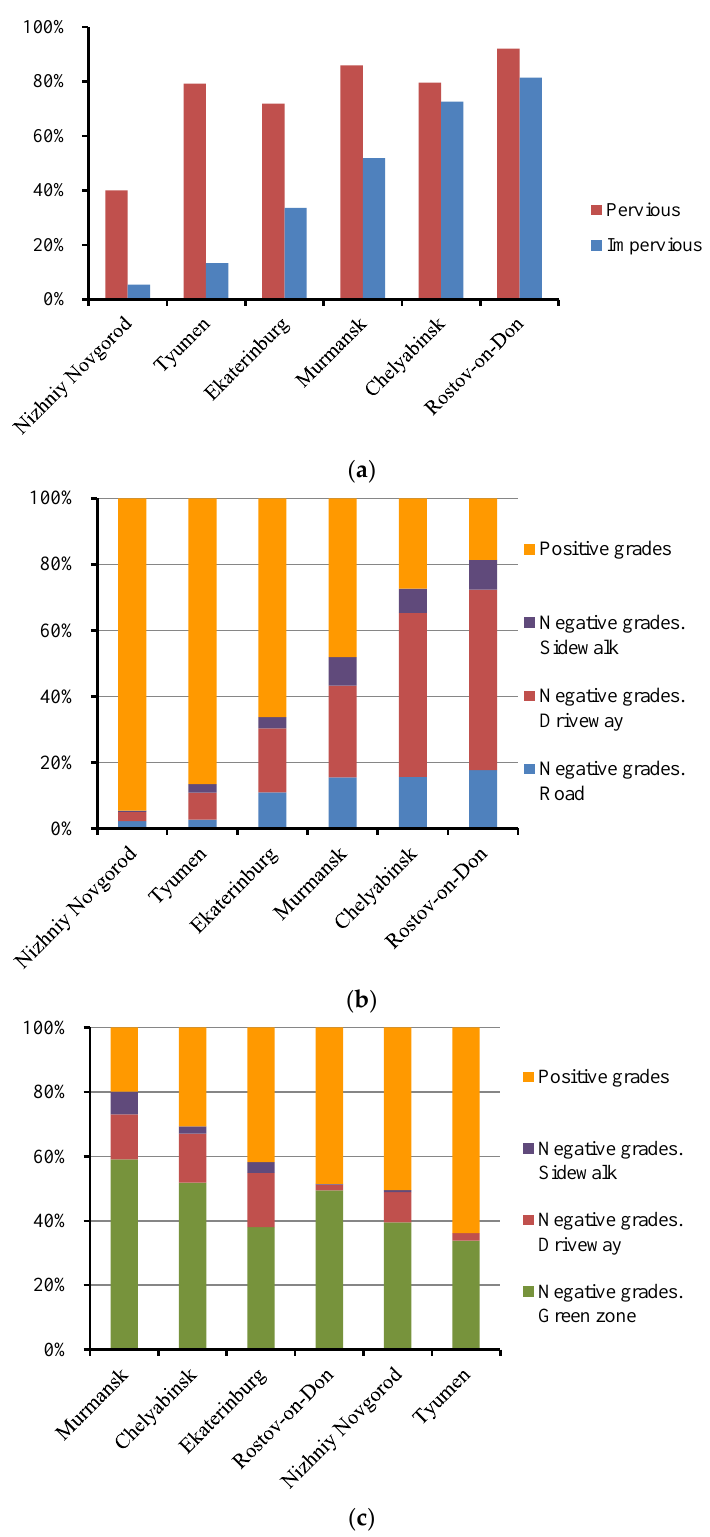
Figure 8. Grades of cleaning quality and technical condition. ( a ) Negative grades of cleaning in segments with pervious and impervious surfaces; ( b ) quality of cleaning by functional zones with impervious surfaces; ( c ) contributions of the main functional zones to the negative grades of the technical